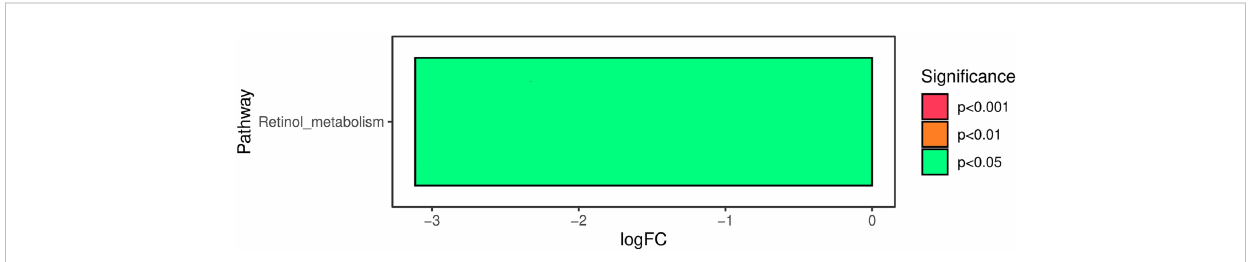
FIGURE 5 Compared with the control group, retinol metabolism was signi fi cantly downregulated in the heart failure group. The negative value of the horizontal axis logFC represents the downregulation of metabolism in the heart failure group compared with the control group. The ordinate represents the different KEGG metabolic pathway labels. The degree of saliency is shown in different